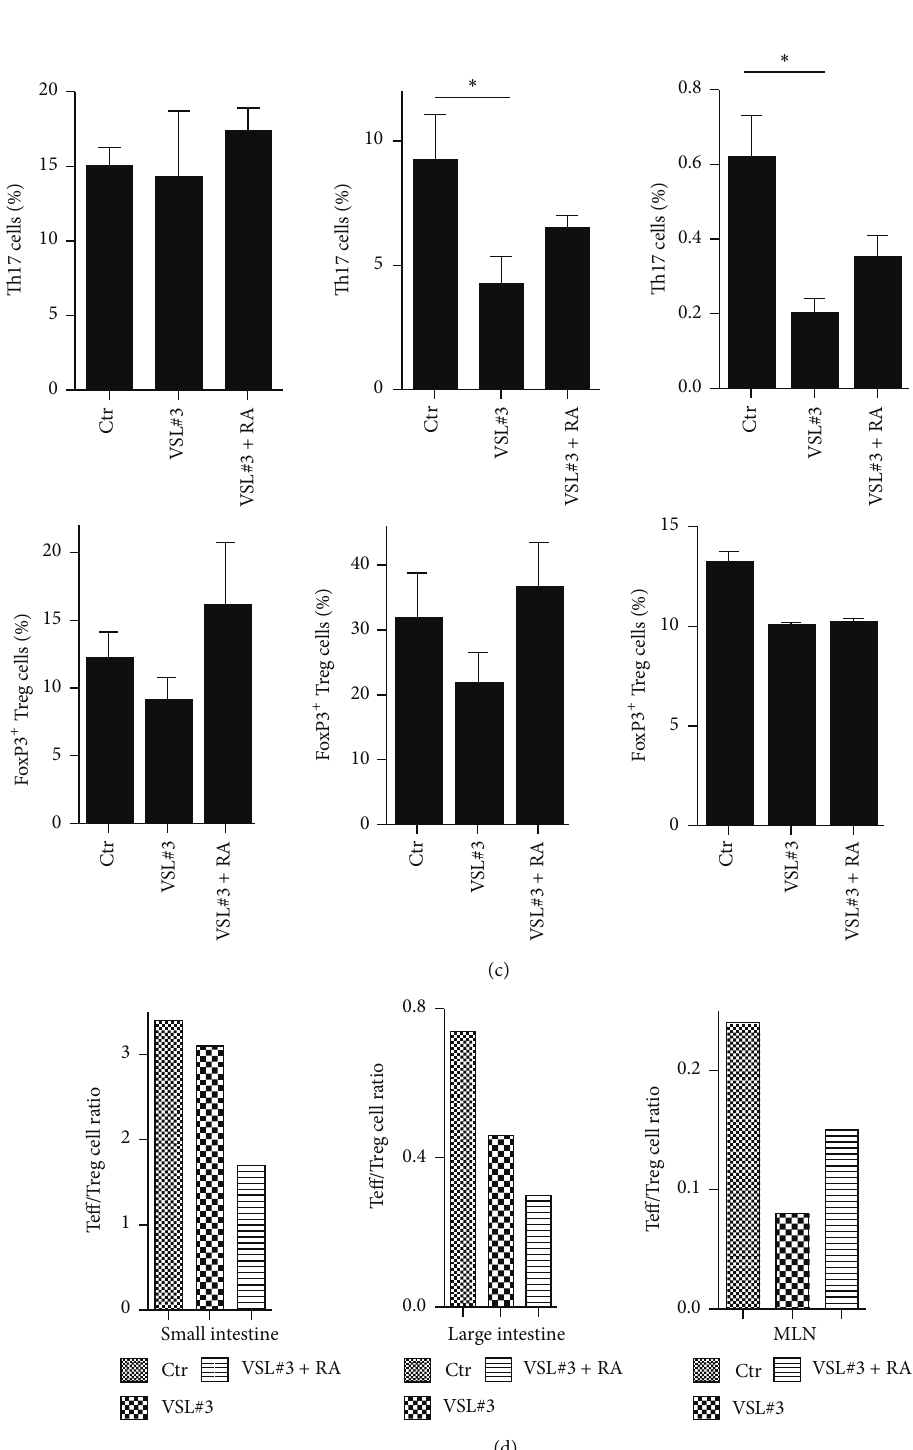
Figure 4: VSL#3 inhibits inflammation by inhibiting effector Th1/Th17 cell differentiation in the gut mucosa. (a) Percentages of different intestinal APC subsets in the small intestine (duodenum, jejunum, and ileum), large intestine (colon), and MLN (mesenteric lymph nodes) of 12-week-old NOD mice that were either untreated or treated with VSL#3 or VSL#3 + RA. Treatments were initiated at 4 weeks of age. (b) The cytokine secretion profile of the intestinal DCs from the gut mucosa of the three groups of NOD mice. CD11c + DCs were purified by magnetic selection and stimulated for 20 hours with LPS (1 𝜇 g/mL). Supernatants were collected and analyzed for cytokine content. The data are expressed as the mean ± SEM of triplicate experiments. (c) The percentages of Th1 cells, Th17 cells (CD4 + CD3 + IL-17A + ), and FoxP3 + Treg cells (CD4 + CD25 + FoxP3 + ) were measured by intracellular staining and FACS analysis and expressed as the mean ± SEM. (d) The data are expressed as Teff (Th1 + Th17)/Treg cell ratios. ∗∗∗ 𝑝 < 0.0005 ; ∗∗ 𝑝 < 0.005 ; ∗ 𝑝 < 0.05 by Student’s 𝑡